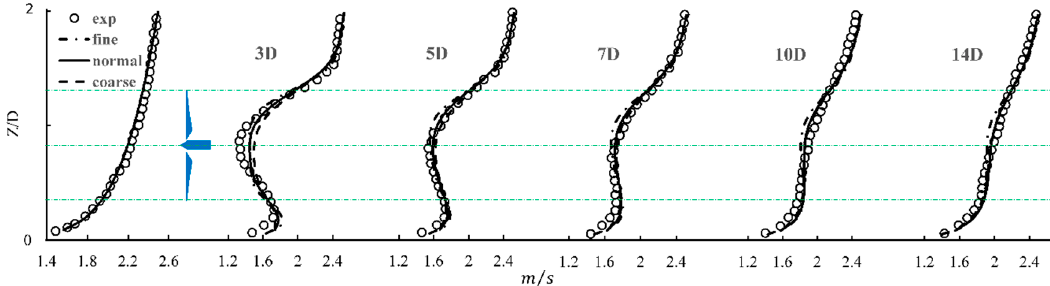
Figure 19. Vertical distribution of stream ‐ wise velocity simulated by different mesh schemes.